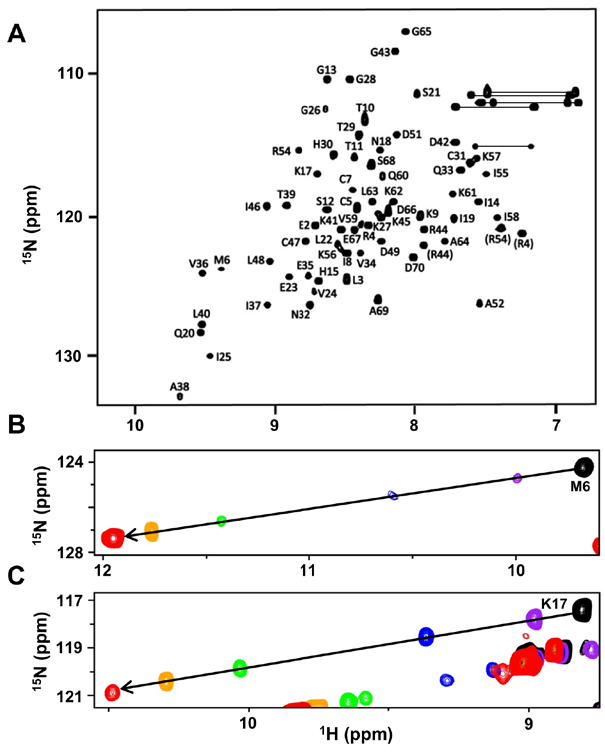
Figure 2. NMR characteristics of the CXCL7 monomer. ( A ) The HSQC spectrum shows excellent chemical shift dispersion indicating a well-folded single species at pH 4.0. The folded arginine side chain peaks are indicated in closed brackets; ( B , C ) Large chemical shift changes observed as a function of pH are shown for M6 and K17. The transition is from pH 4.2 (black), 4.4 (purple), 5.0 (blue), 5.5 (green) 6.0 (orange) to 7.0 (red).